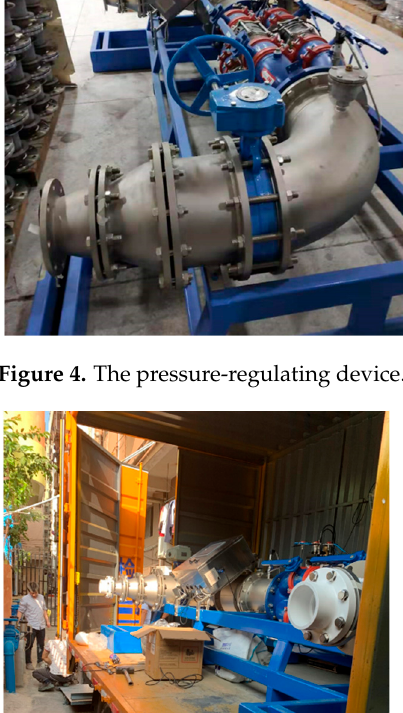
Figure 3. Pressure-regulating device scheme .